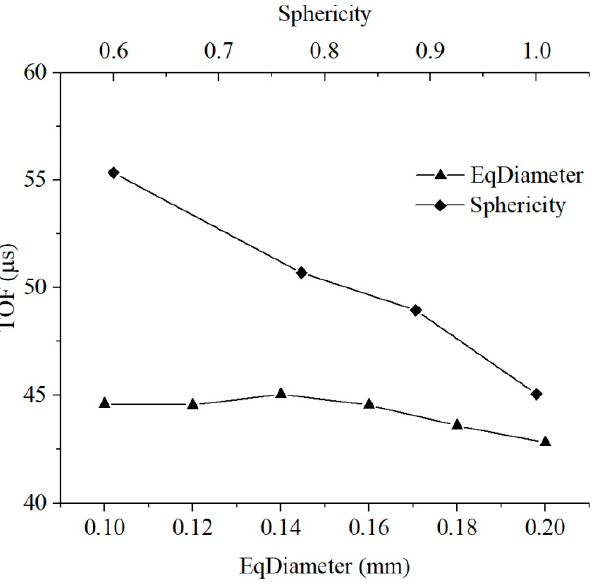
Figure 12. Relationship between sphericity, equivalent diameter, and time of flight (TOF). 3.5. Effect of Porosity on Strength, Stiffness, and Ultrasonic Pulse Velocity of Soils Porosity is a measure of the total amount of pores. Area porosity is defined as the ratio of the projected area of pores to the total area of the object. The porosities of the untreated and consolidated soils were in the range of 20–45%. The porosities of the medium were set to 0, 10.23%, 19.27%, 29.15%, and 40.67% (Figure 13). Parameters remained the same for all RVEs except for the porosity, and the equivalent diameter of the circular pore was 0.14 mm. For the same RVE, all pores were identical and randomly distributed.